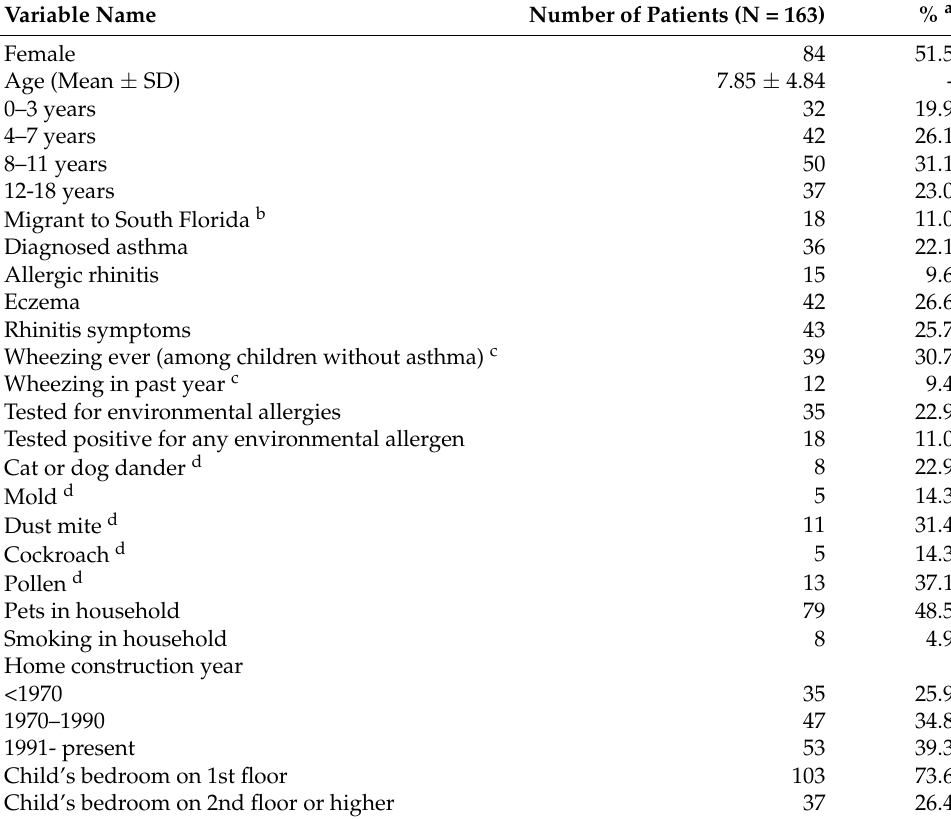
Table 1. Demographic and clinical characteristics of children attending two pediatrics clinics in